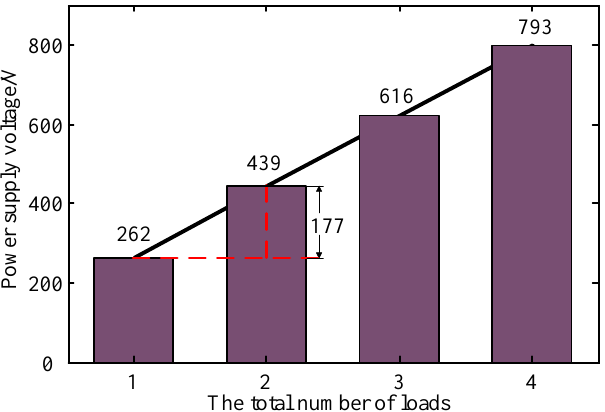
Figure 7. The relationship between the power source voltage and the number of loads.